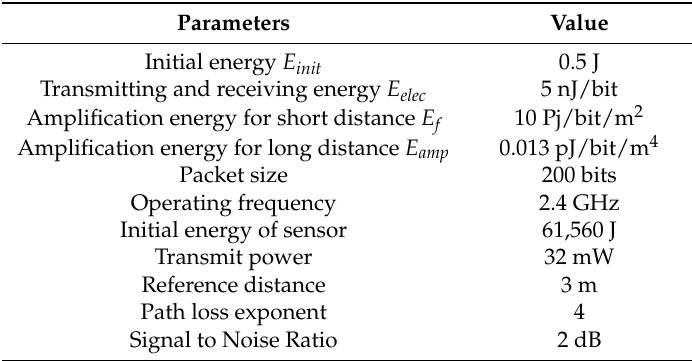
Table 1. Simulation parameters.